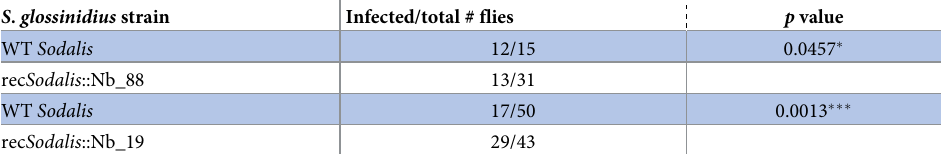
Table 3. In vivo microscopic evaluation of the influence of the presence of WT S . glossinidius , rec Sodalis ::Nb_88 or rec Sodalis ::Nb_19 on the midgut trypanosome infection establishment. The effect of each rec Sodalis strain was compared to a WT S . glossinidius control in independent experiments. Differences in infection rates were compared using Chi-square (two-sided) and considered significant if p-values were lower than